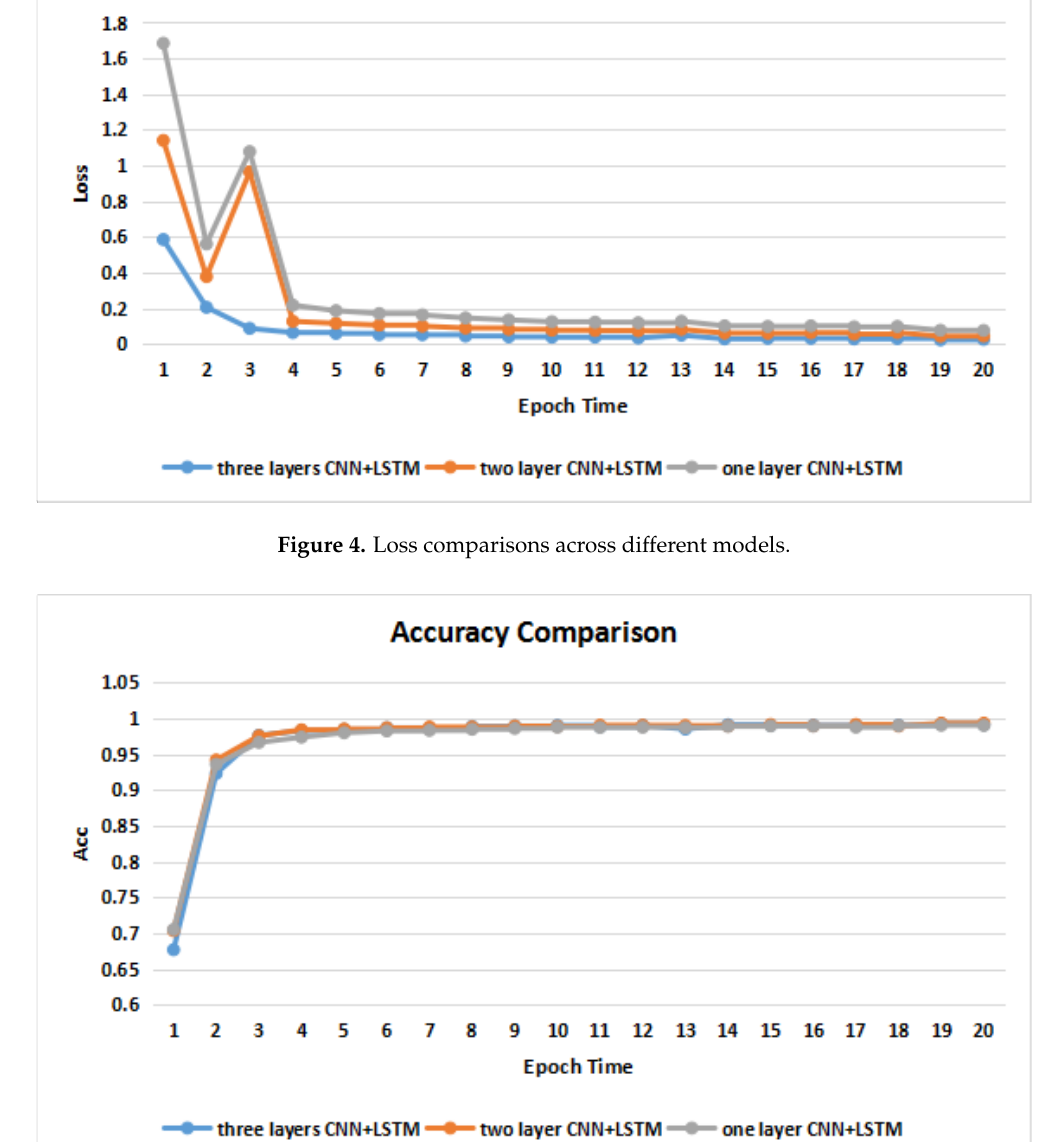
Figure 5. Accuracy comparisons across different